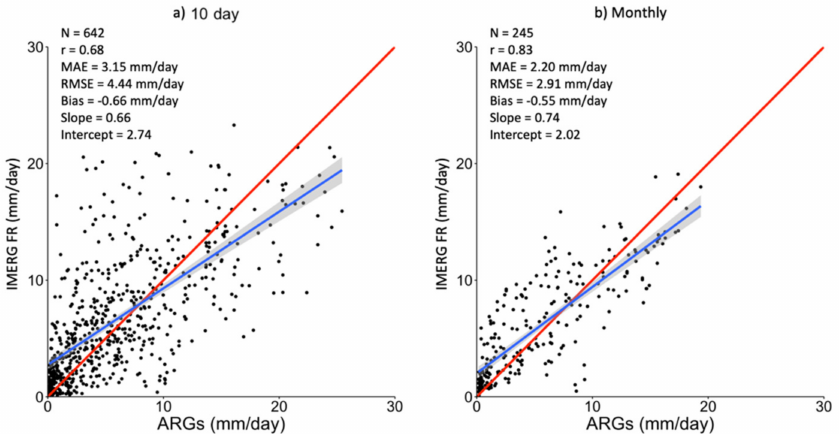
Figure 10. Scatter plot of raw IMERG FR ( a ) 10 day and ( b ) monthly values versus the average of corrected ARG measurements within the footprint of IMERG FR. Red line depicts 1:1 rainfall values. Blue line indicates linear regression results with